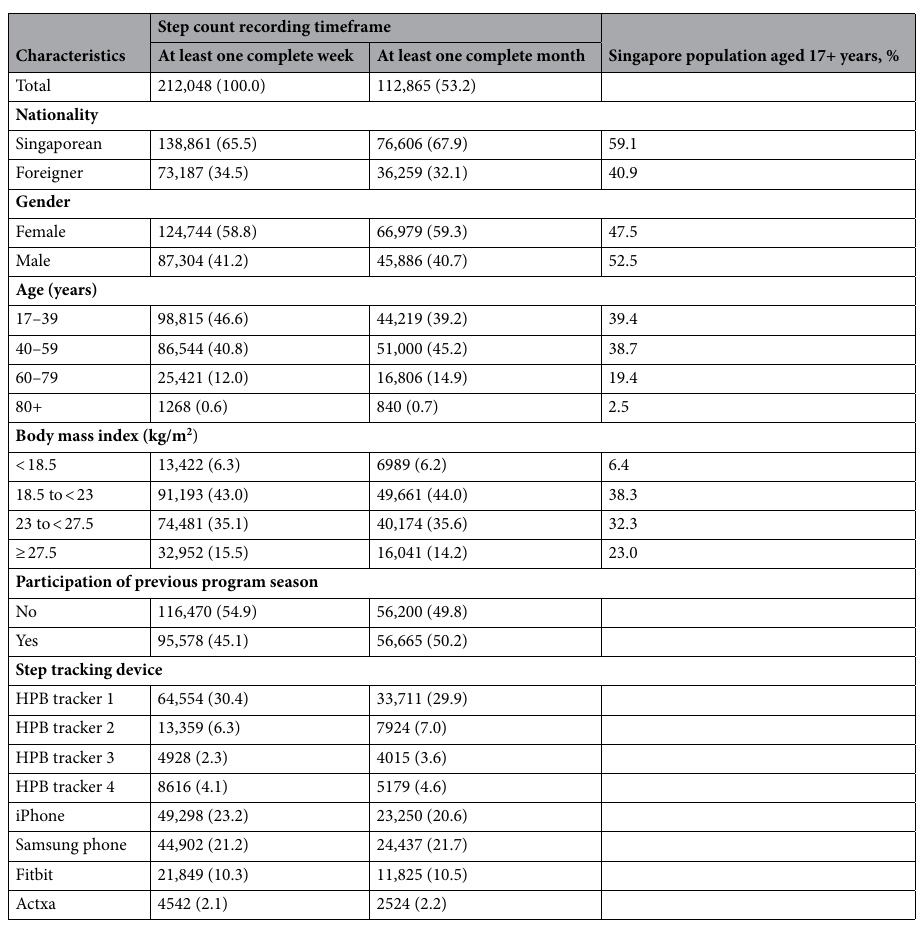
Table 1. Characteristics of participants (N = 212,048). Data are in N (%). All p-value < 0.001 by the Chi- Squared tests comparing the participant characteristics with the entire Singapore population aged 17+ years. HPB Health Promotion